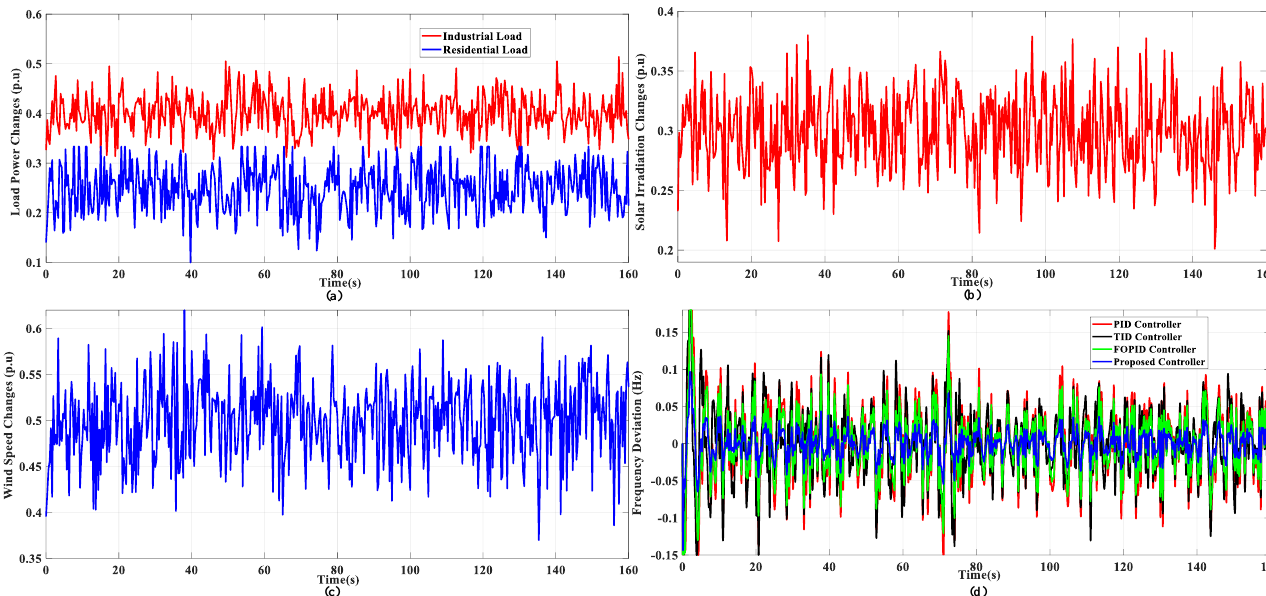
Figure 7. Perturbations and simulation result for scenario 3. ( a ) Load disturbances. ( b ) Wind speed changes. ( c ) Solar irradiation changes. ( d ) Obtained frequency responses.